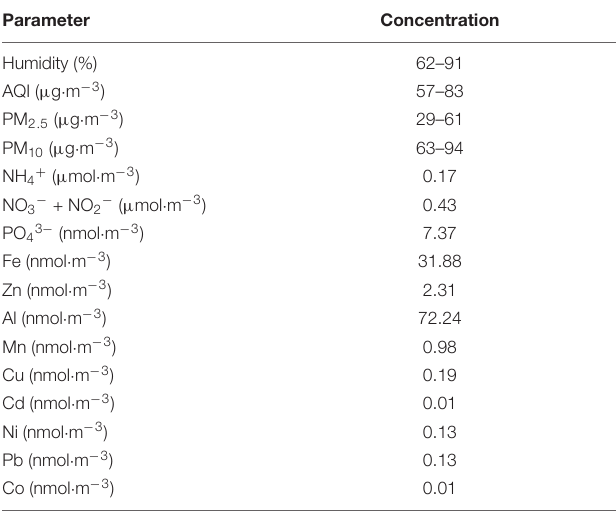
TABLE 1 | Air quality conditions during the anthropogenic aerosol (AR) sampling